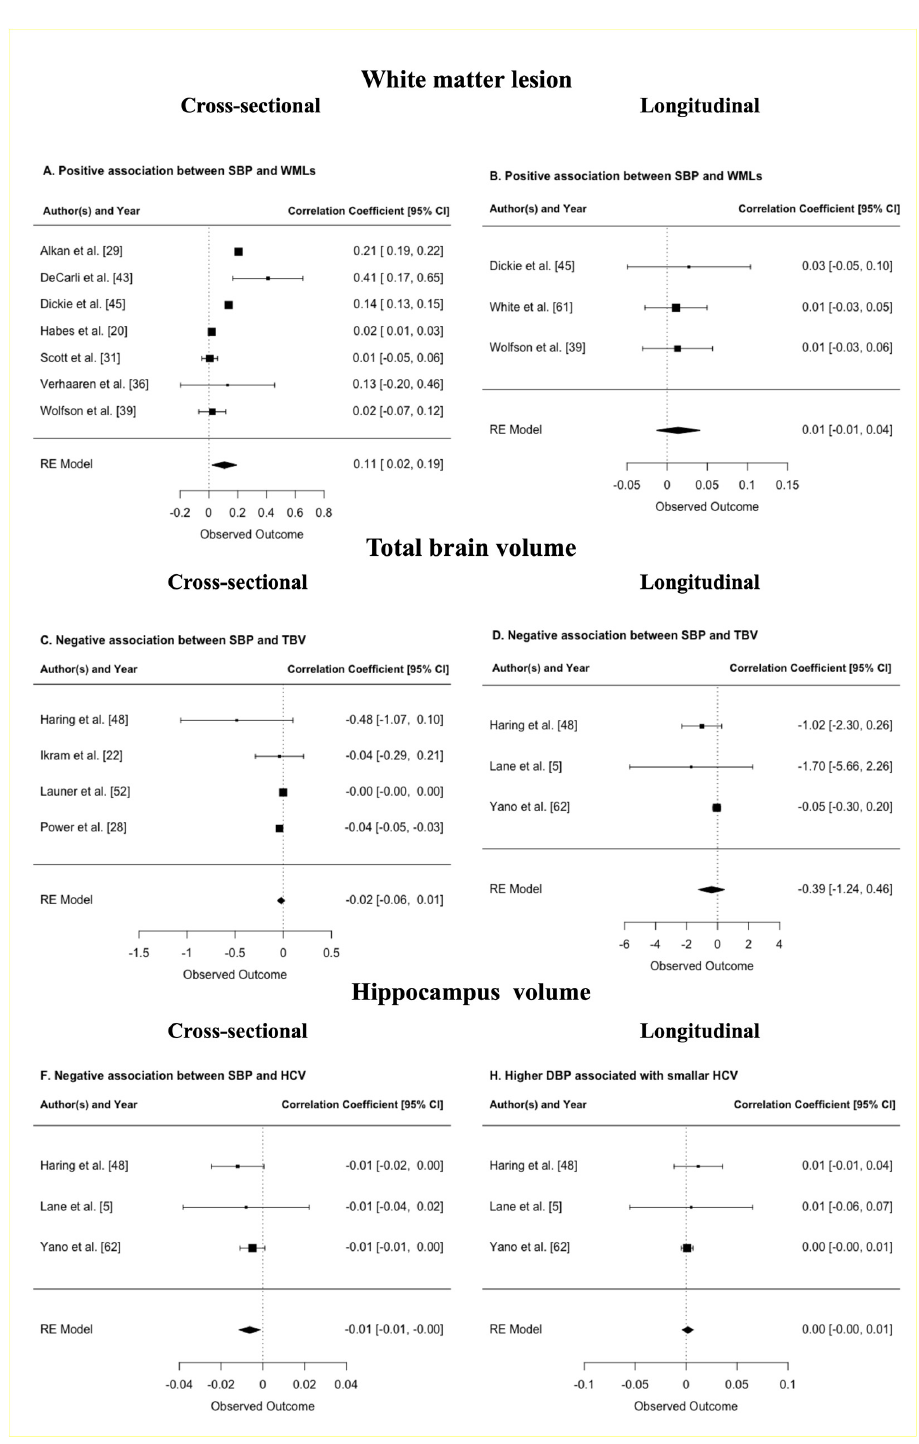
Figure 5. Forest plots of analyses investigating the association between continuous systolic blood pressure (SBP) and brain volumes in cm 3 ; ( A ) shows a positive association between SBP and white matter lesions (WMLs) in cross-sectional studies; ( B ) shows a positive association between SBP and WMLs in longitudinal studies; ( C ) shows a negative association between SBP and total brain volume (TBV) in cross-sectional studies; ( D ) shows a negative association between SBP and TBV in longitudinal studies; ( E ) shows a negative association between SBP and smaller hippocampus volume (HCV) in cross-sectional studies; and ( F ) shows a negative association between SBP and HCV in longitudinal studies. The effect size is a standardized beta-coefficients. The sizes of the squares reflect the weight given to each effect size.